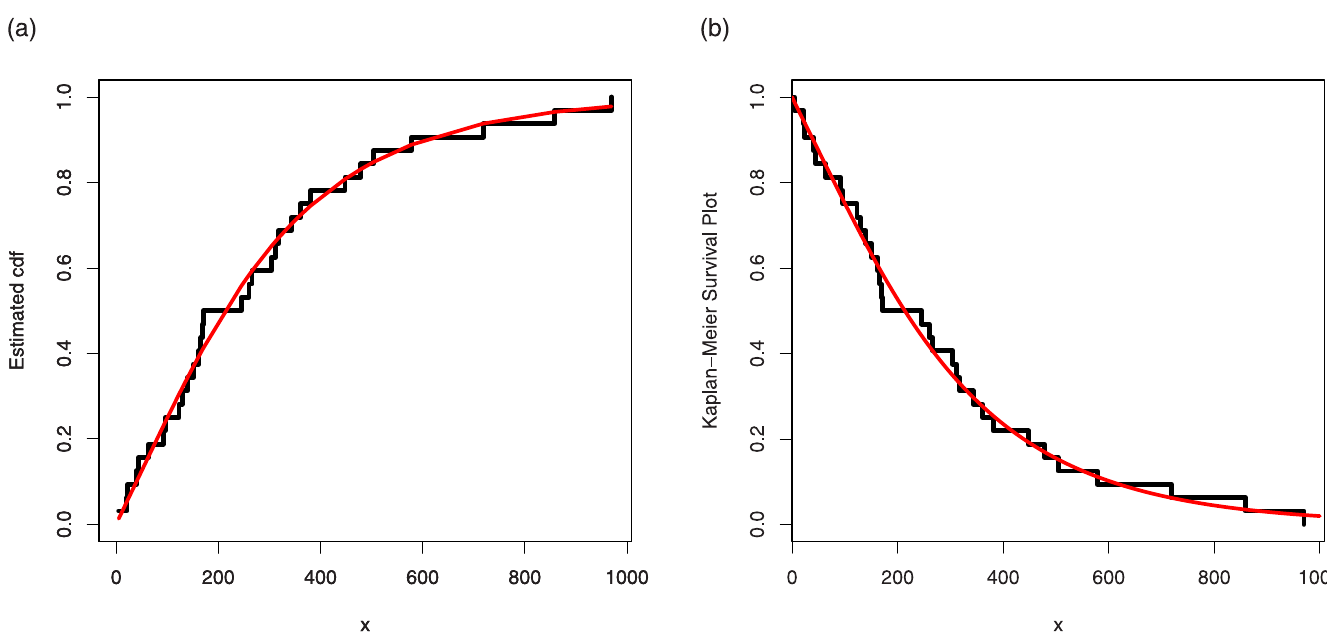
Fig 11. Estimated cdf and Kaplan Meier survival plots of the TI-HTW distribution for data 3.